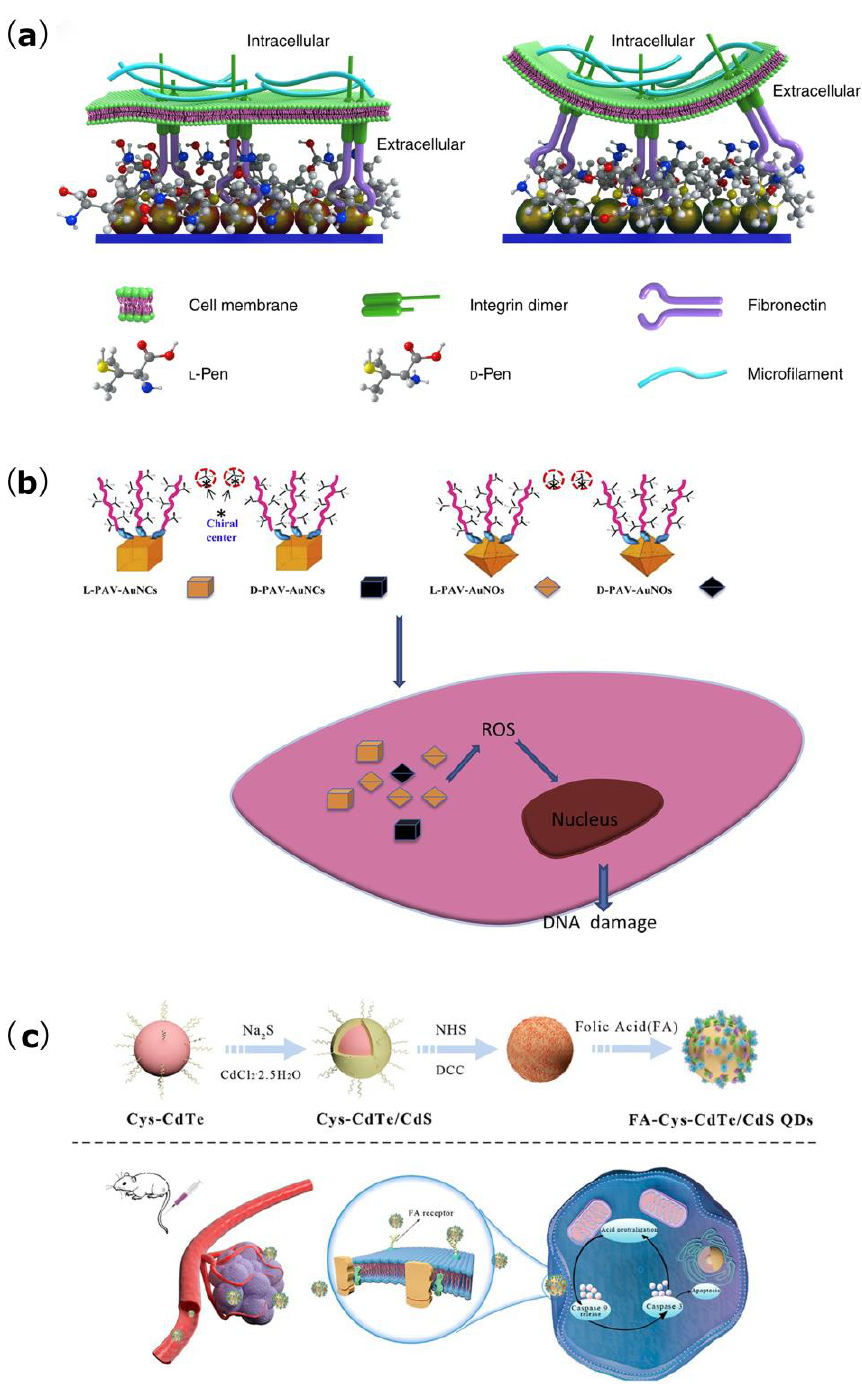
Figure 3. ( a ) Schematic presentation of the regulation of NG108-15 cell adhesion by the stereospecific interaction between fibronectin and the chiral NP film (reproduced with copyright permission from [73], Springer Nature). ( b ) The structure and surface chirality at the nanoscale can influence cytotoxicity and genotoxicity (reproduced with copyright permission from [75], Elsevier Ltd.). ( c ) Synthesis of chiral FA-Cys-CdTe/CdS QDs and illustration of their effect in synergistic cancer therapy by the caspase-dependent apoptosis pathway (reproduced with copyright permission from [108], American Chemical Society).